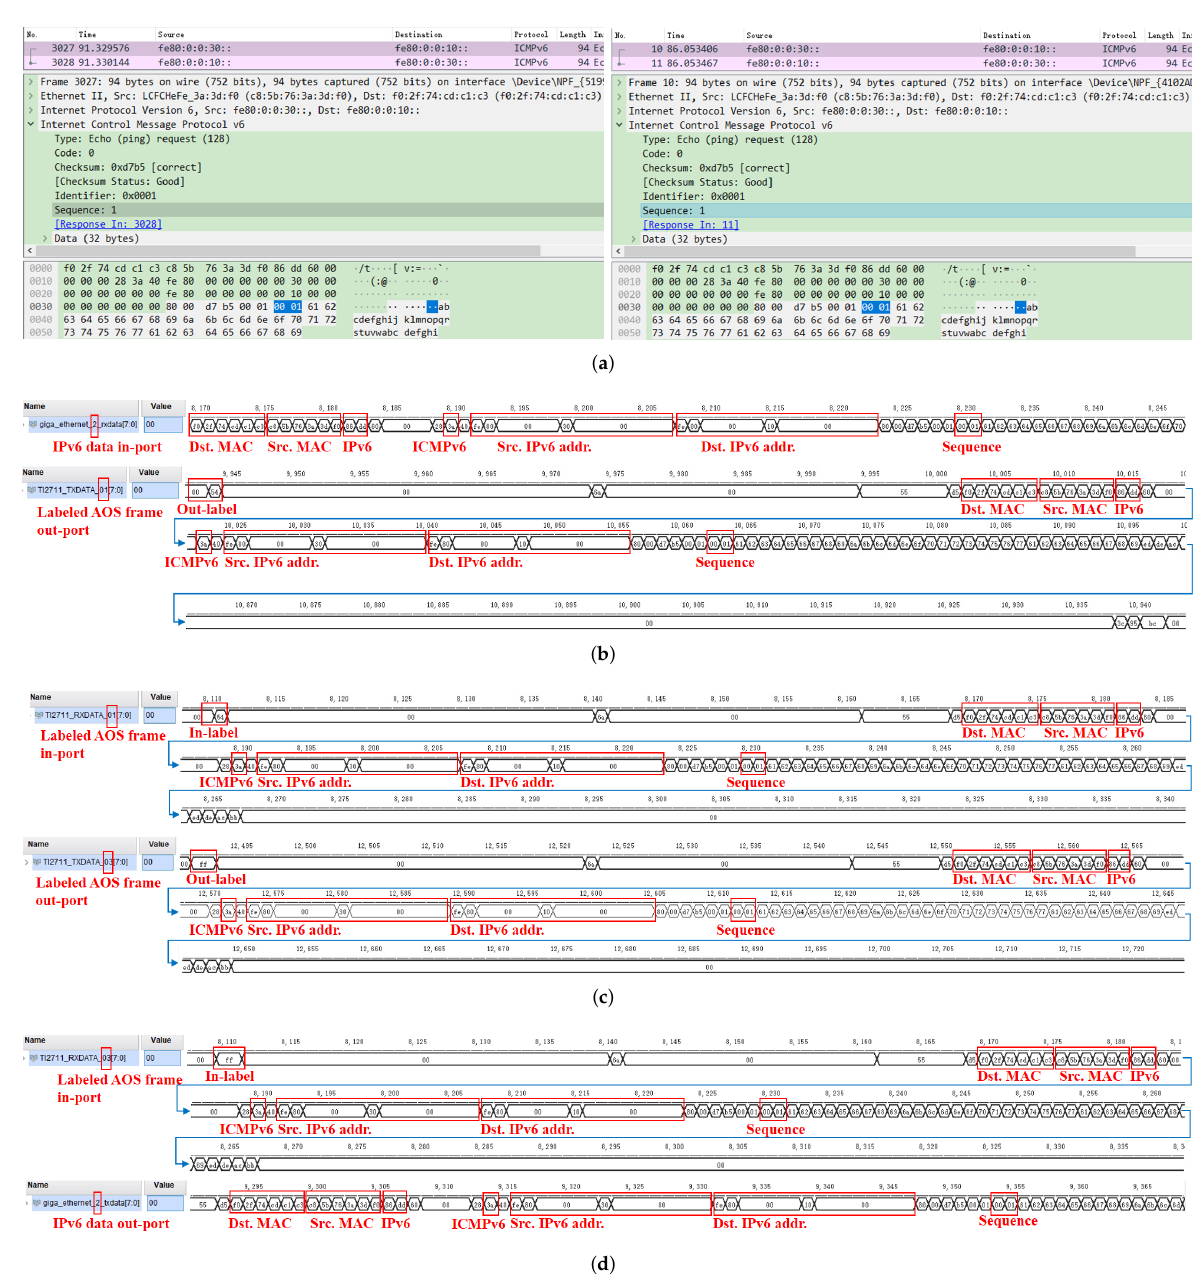
Figure 23. The label-based AOS frame switching in backward label switching path under the circumstances of bi-directional link between node vx_simulator_01 (ingress LER, SCID 1), node vx_simulator_02 (LSR, SCID 2), and node vx_simulator_03 (egress LER, SCID 3) in the semi- physical platform. ( a ) The IPv6 data transmitted from node vx_simulator_03 (SCID 3) to node vx_simulator_01 (SCID 1). ( b ) The backward-FIB-based label pushing of AOS frame in node vx_simulator_03 (SCID 3). ( c ) The backward-LFIB-based label swapping of AOS frame in node vx_simulator_02 (SCID 2). ( d ) The backward-FIB-based label popping of AOS frame in node vx_simulator_01 (SCID